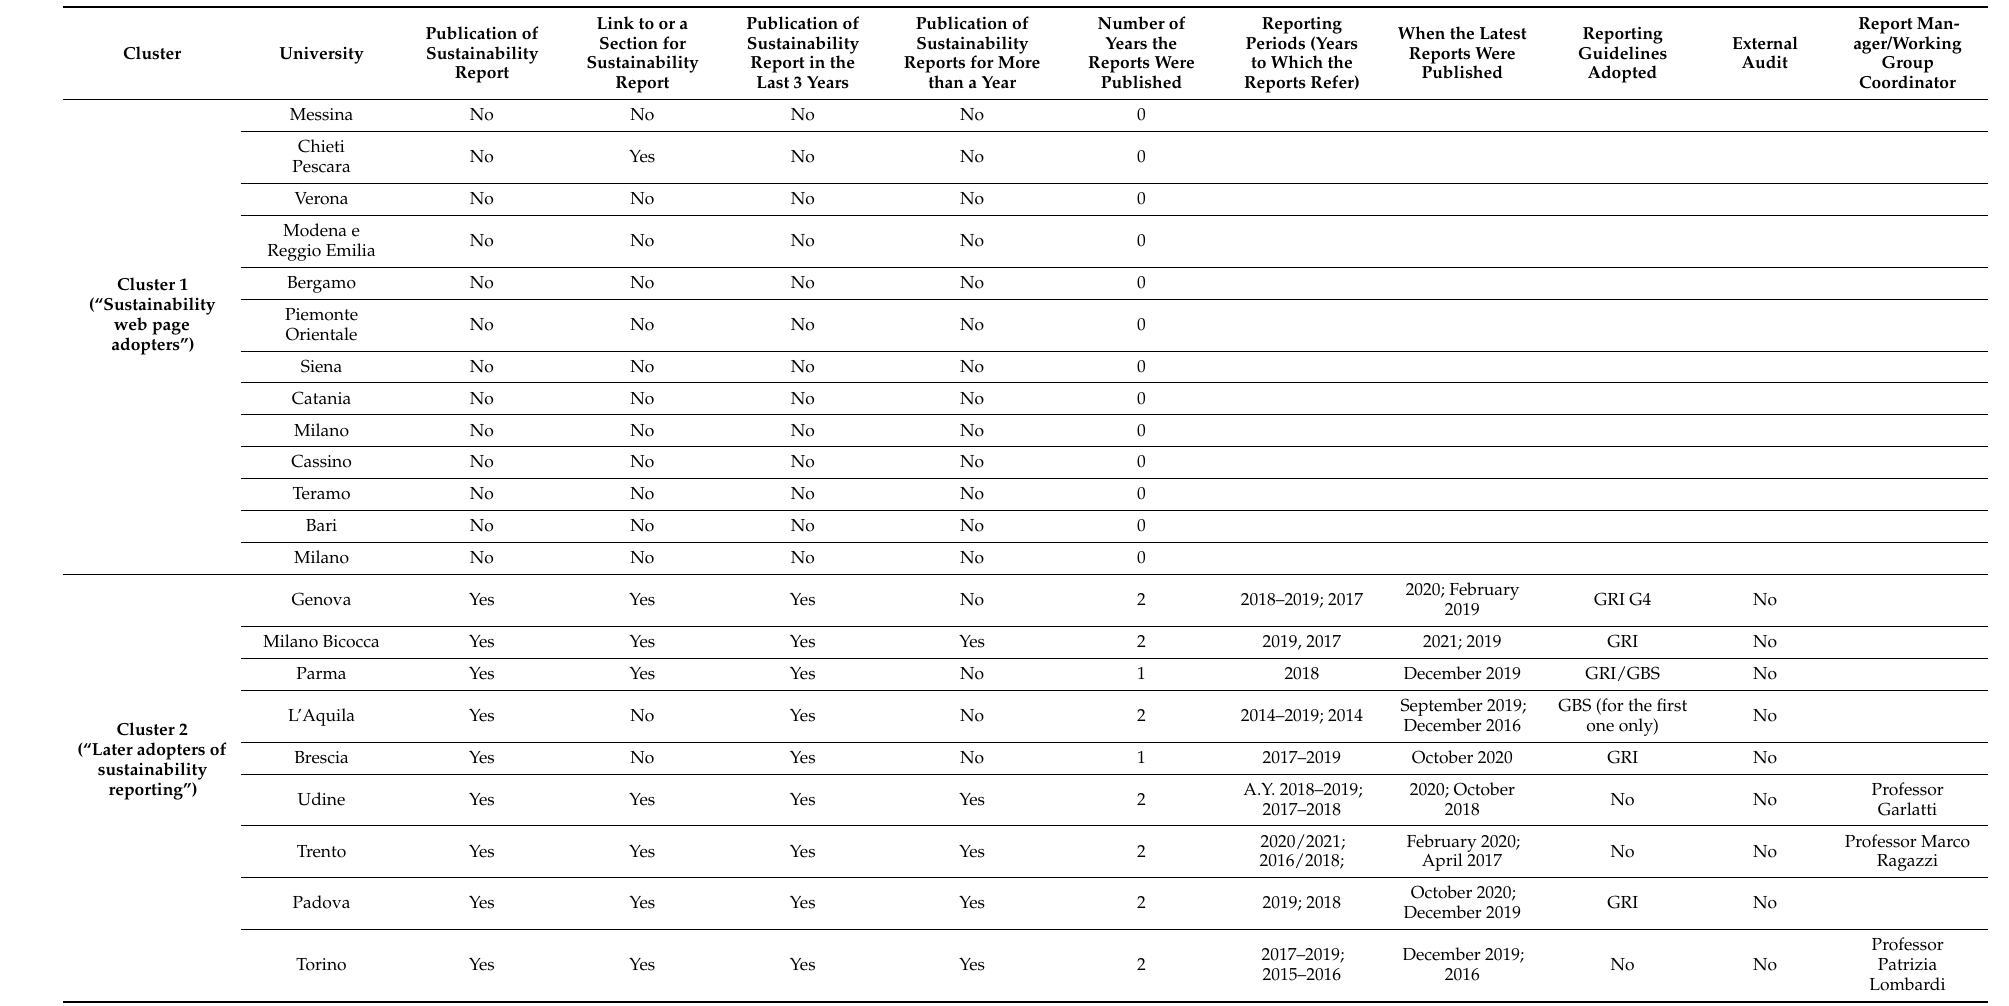
Table 2. A summary of reporting